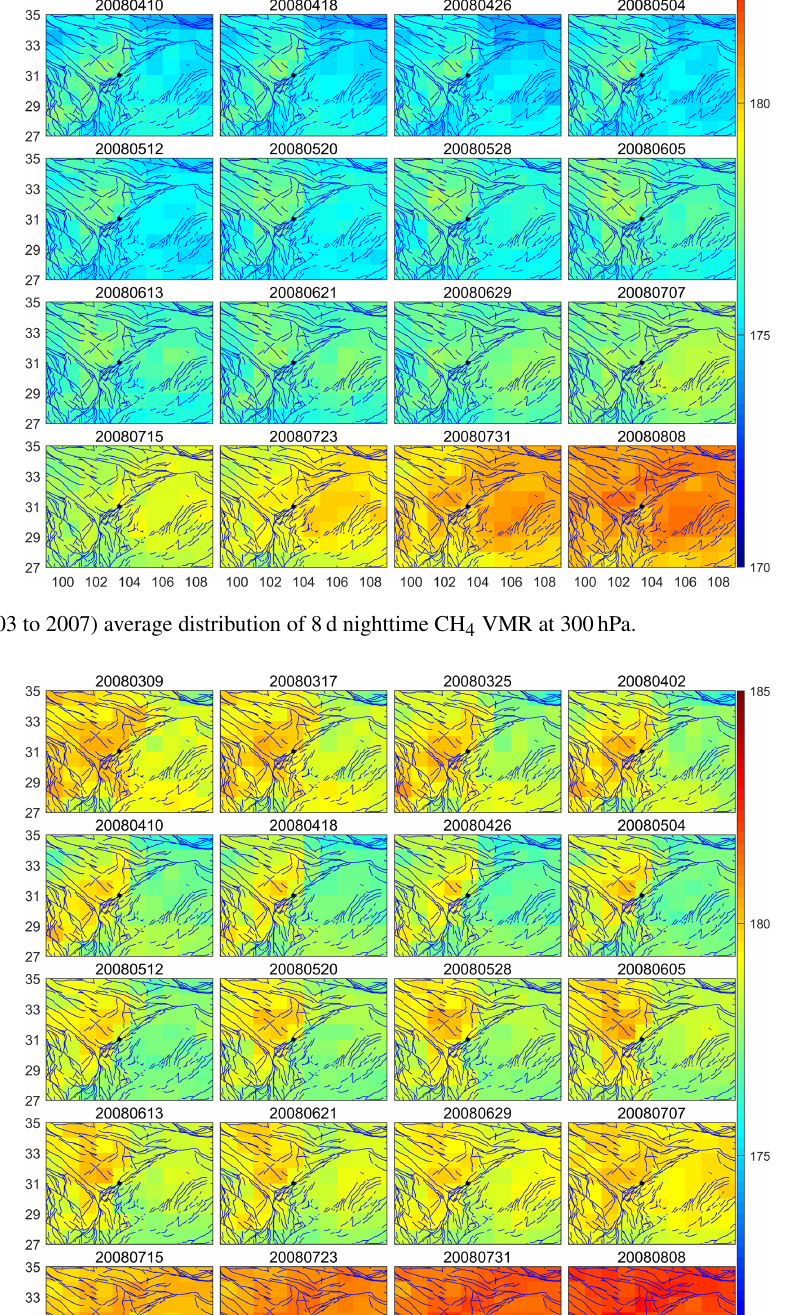
www.nat-hazards-earth-syst-sci.net/19/2841/2019/ Nat. Hazards Earth Syst. Sci., 19, 2841–2854,